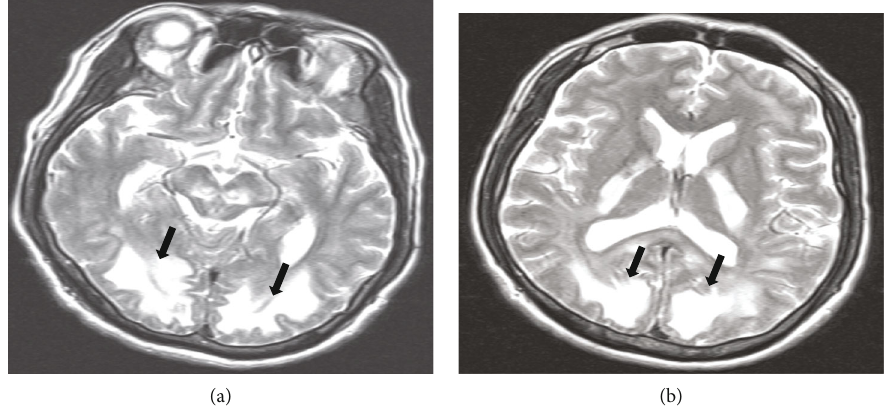
Figure 2: (a, b) T2-weighted Magnetic Resonance Imaging of the brain, showing abnormal signal changes in the periventricular white matter, severe in occipital lobe regions, with mass e ff ect on pons and